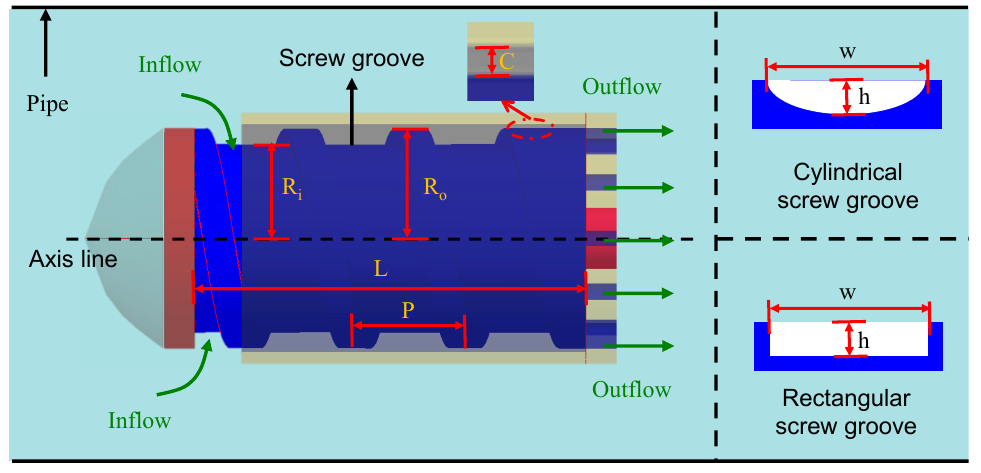
Figure 1. Conceptual design of the microrobot with shrouded propeller ( a ) overall view; ( b ) perspective view.